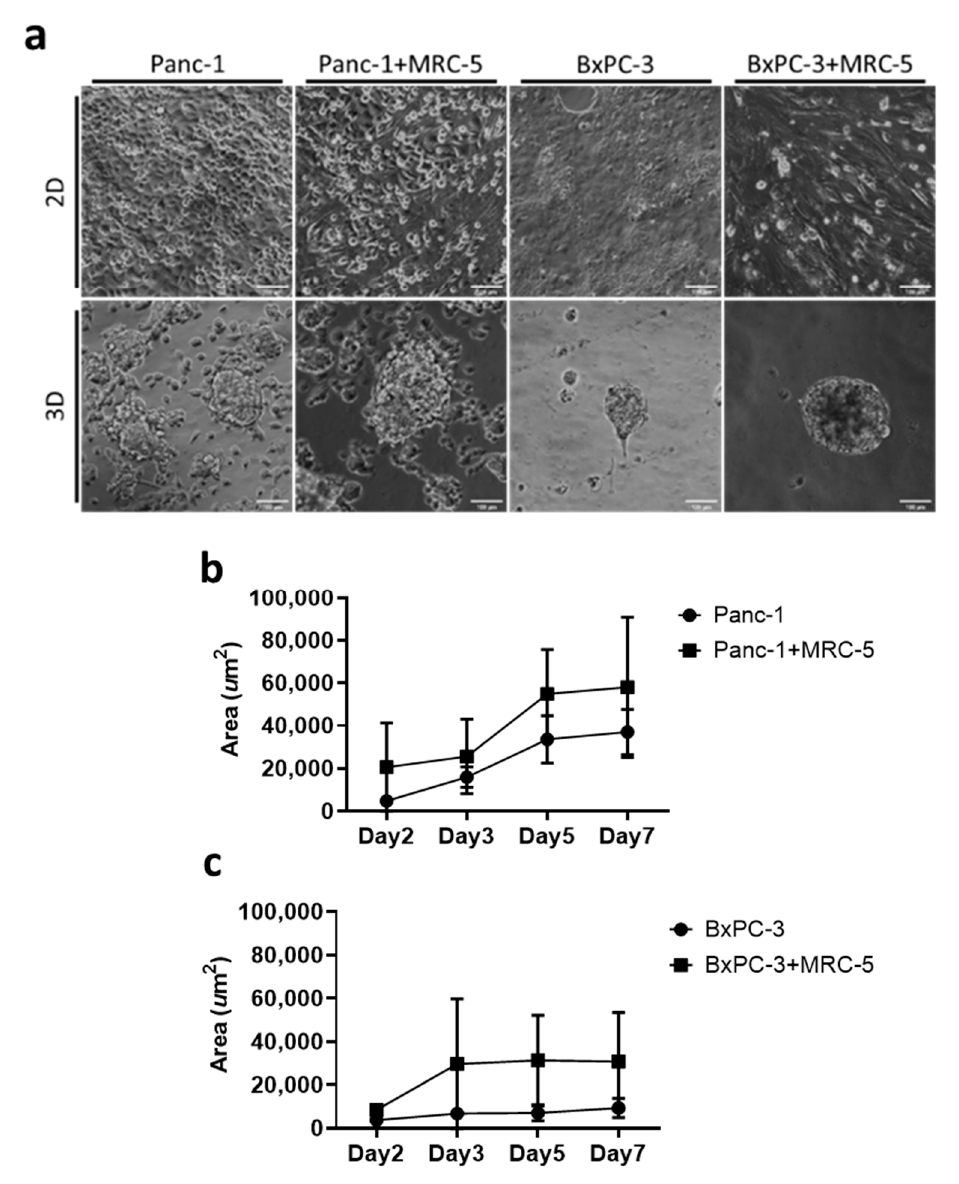
Figure 1. The formation of 3D tumoroids in an in vitro culture system. ( a ) Bright field images of pancreatic cancer cells Panc-1 and BxPC-3 with and without MRC-5 for 7 days in 2D and 3D conditions. Scale bar = 100 µ m. (20 × Magnification) ( b , c ) The tumoroid area was quantified using ImageJ 1.53j software; means and standard deviations are presented for each sample (average ± SD, n = 10).